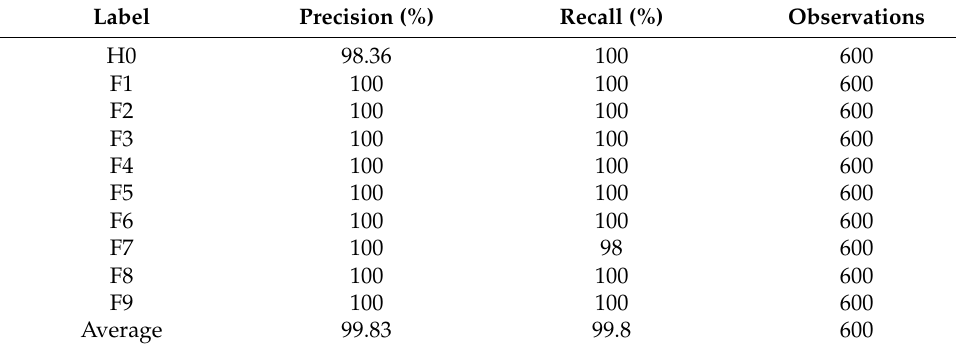
Table 4. The diagnosis result evaluation of improved